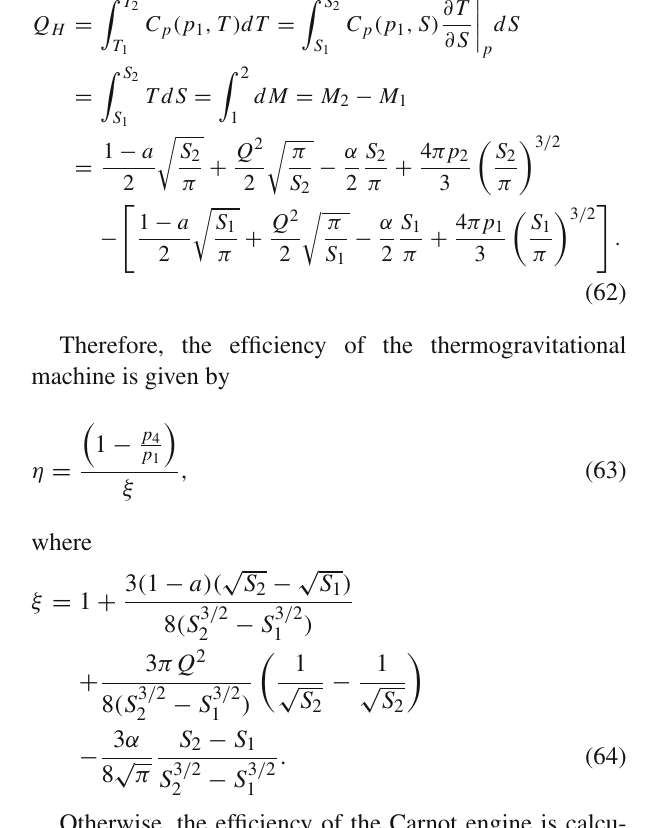
Fig. 9 p x V diagram of a heat engine operating by two isobaric and two isochoric processes